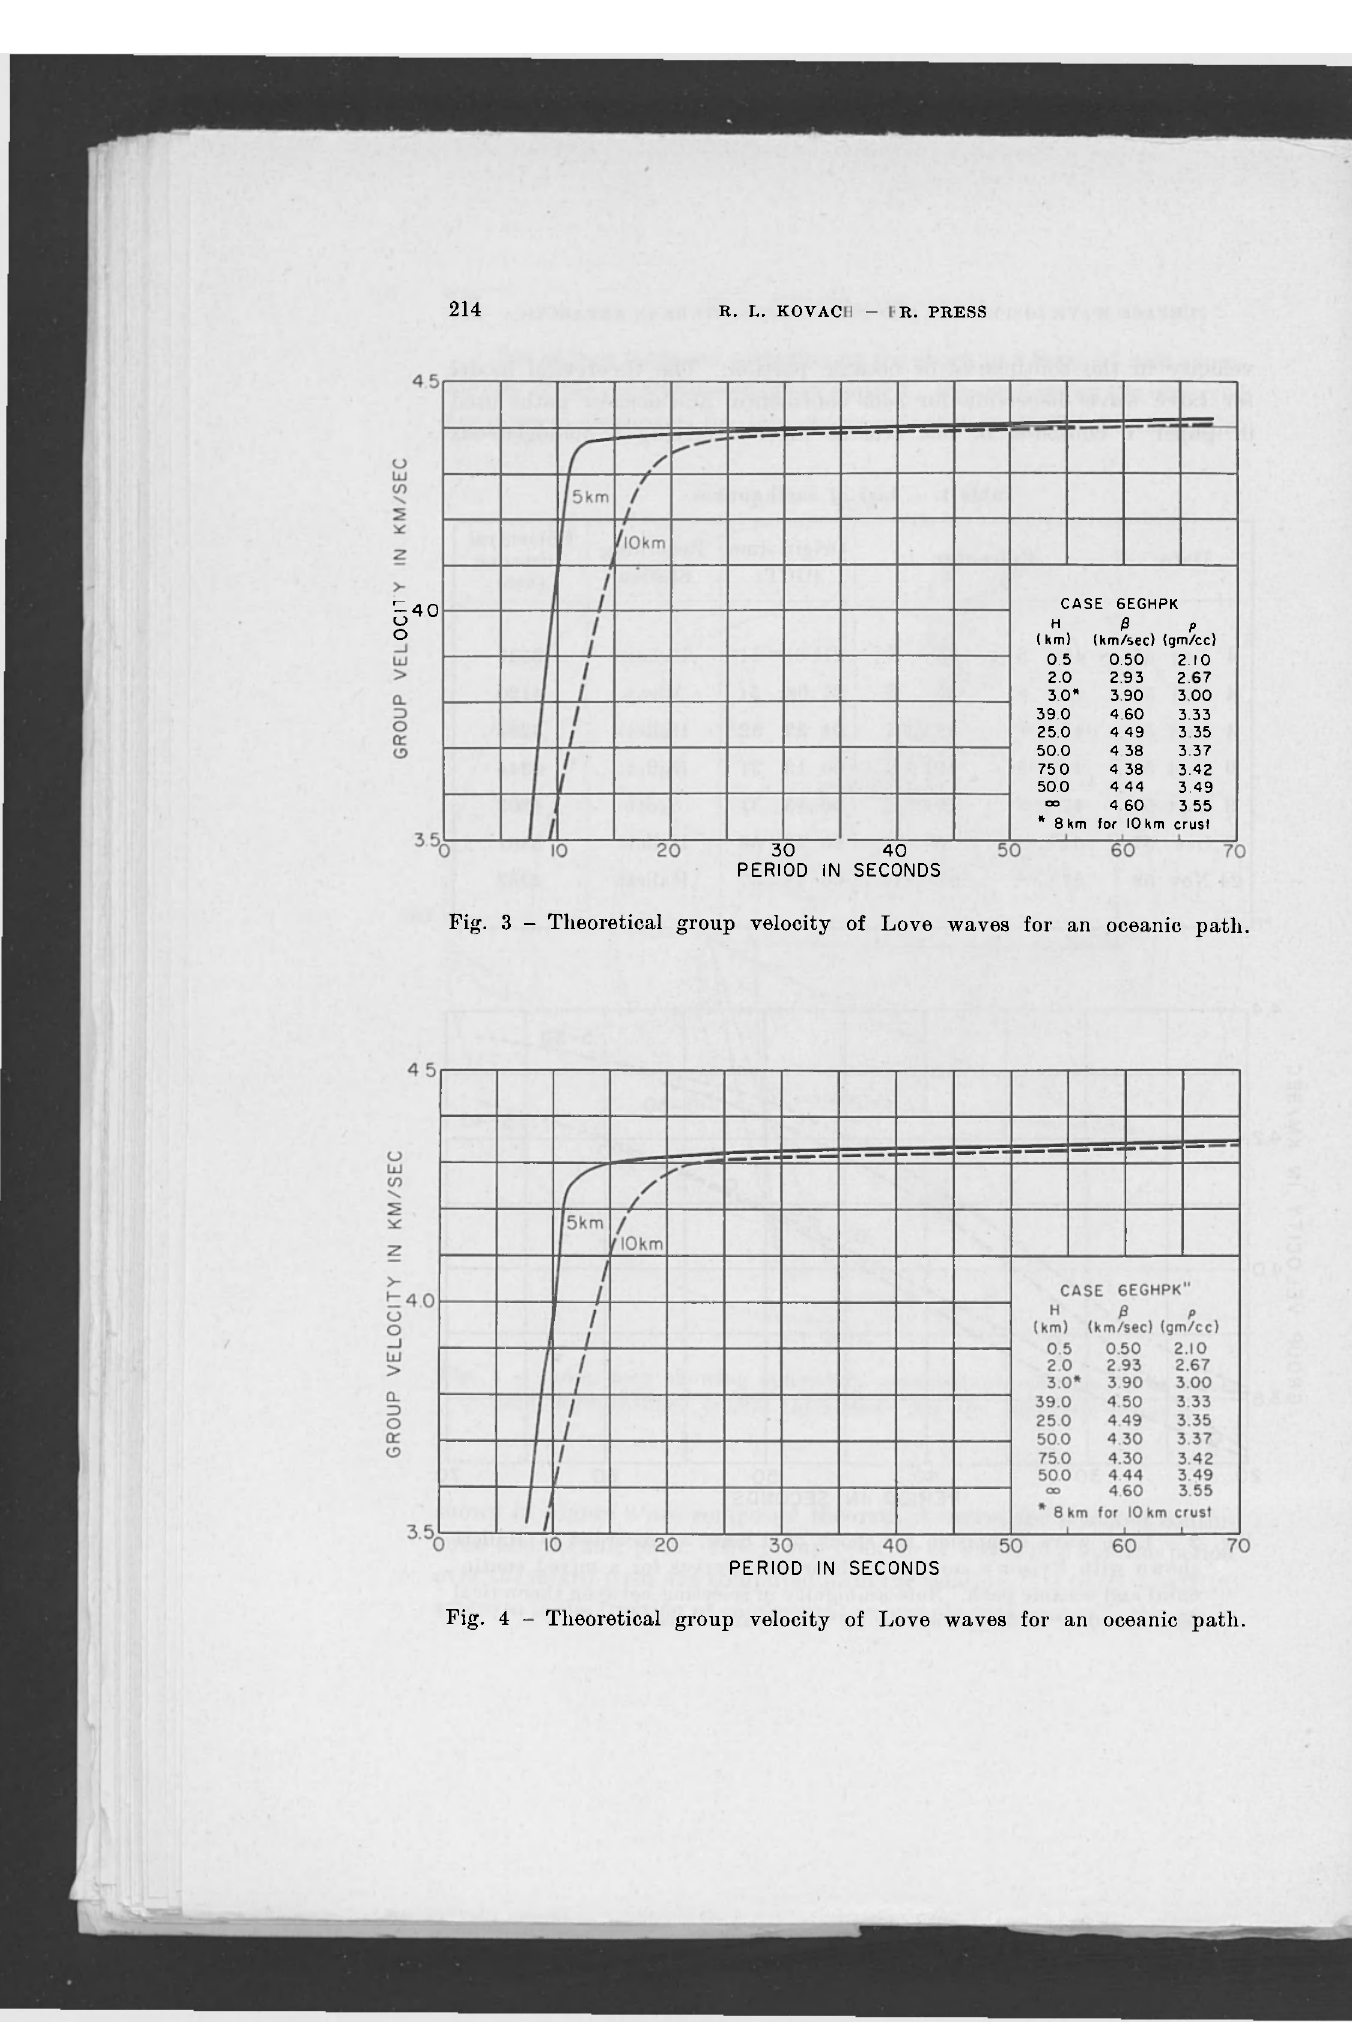
Fig. 4 - Theoretical group velocity of Love waves for an oceanic